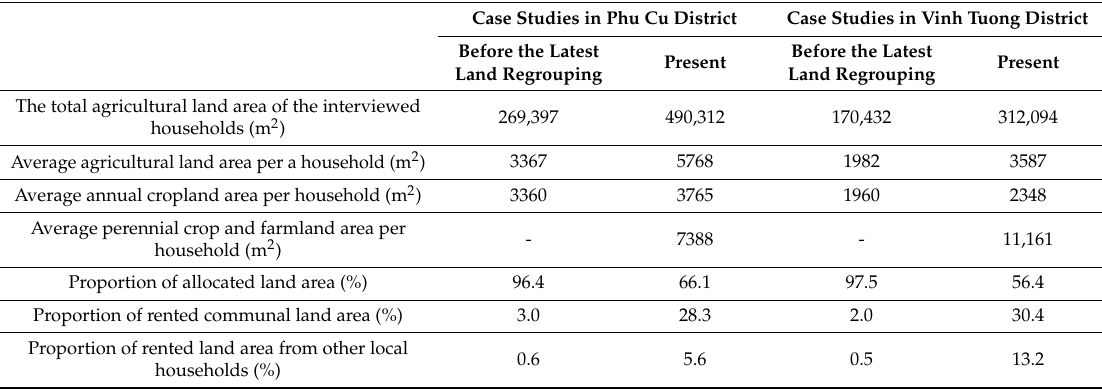
Table 4. Transformation of the structure of agricultural land use area.of the interviewed households during land